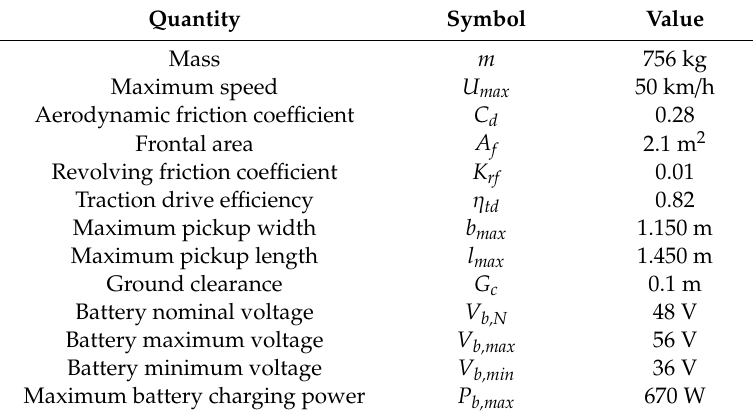
Figure 1. Picture of the case study electric vehicle (EV) Urbe. Table 1. Urbe data.